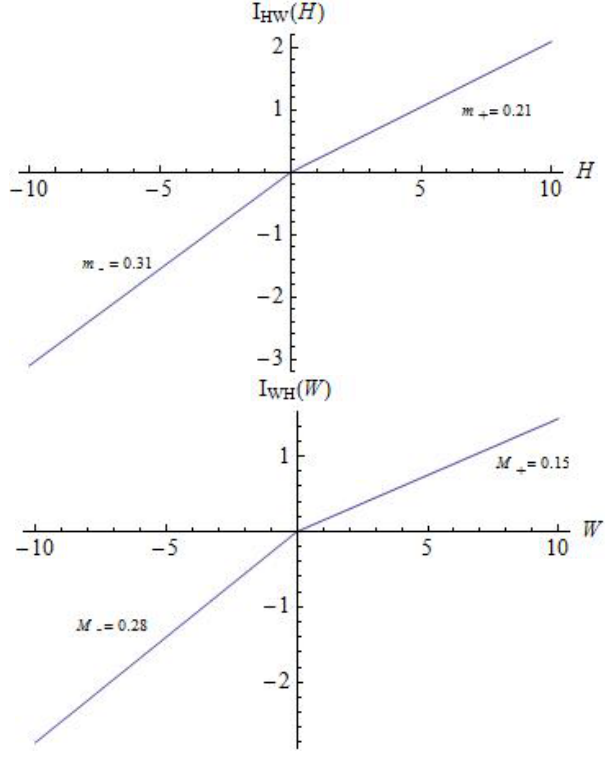
Figure 1. Bilinear influence functions I HW ( H ) ( top ) and I WH ( W ) ( bottom